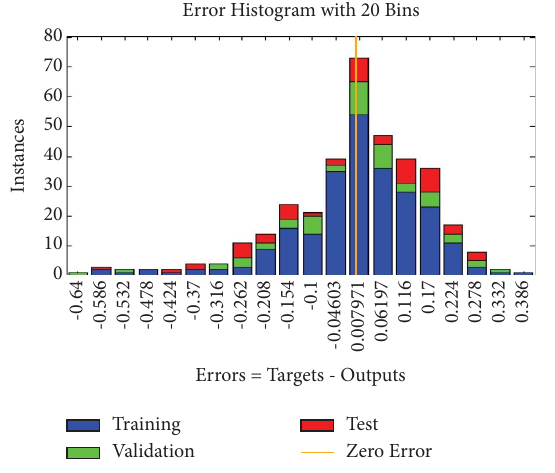
5: Proposed wavelet-ANN training